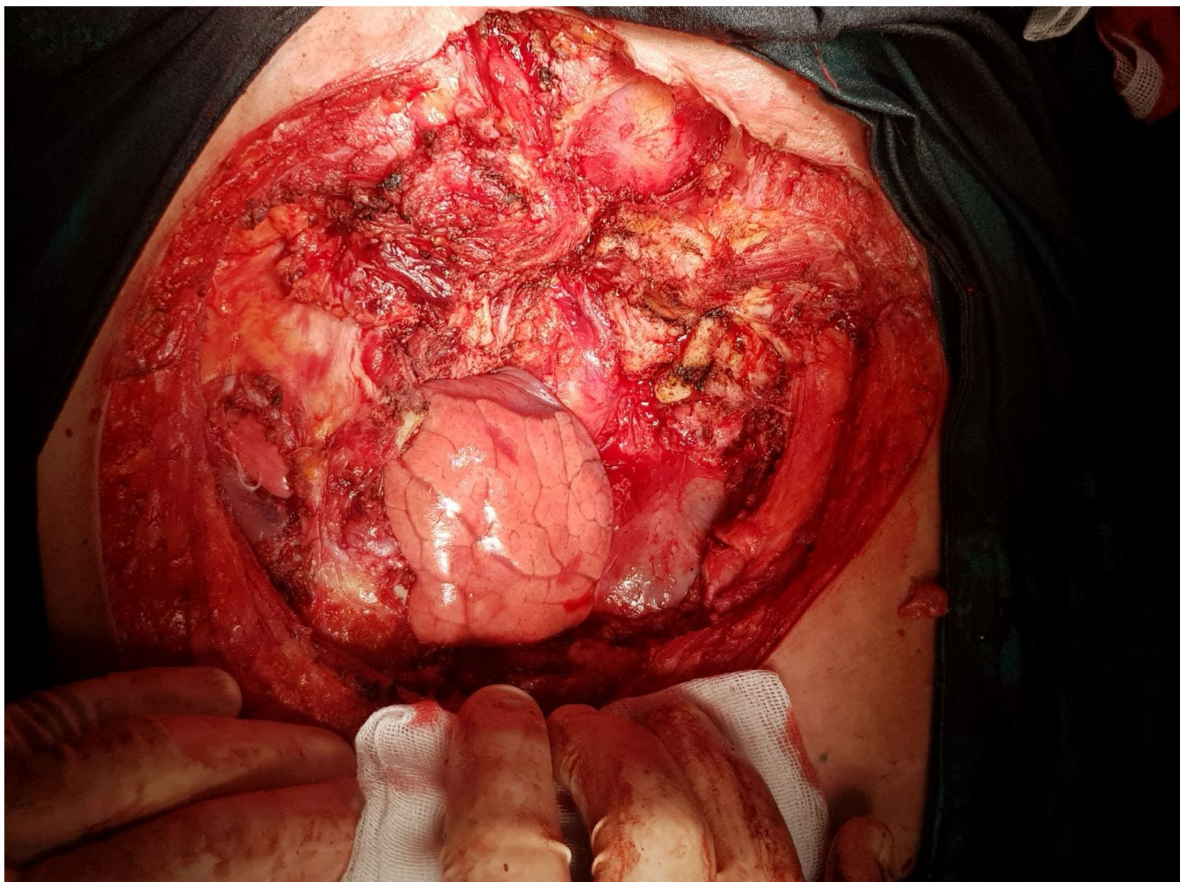
Figure 10. Intraoperative aspect, after tumor